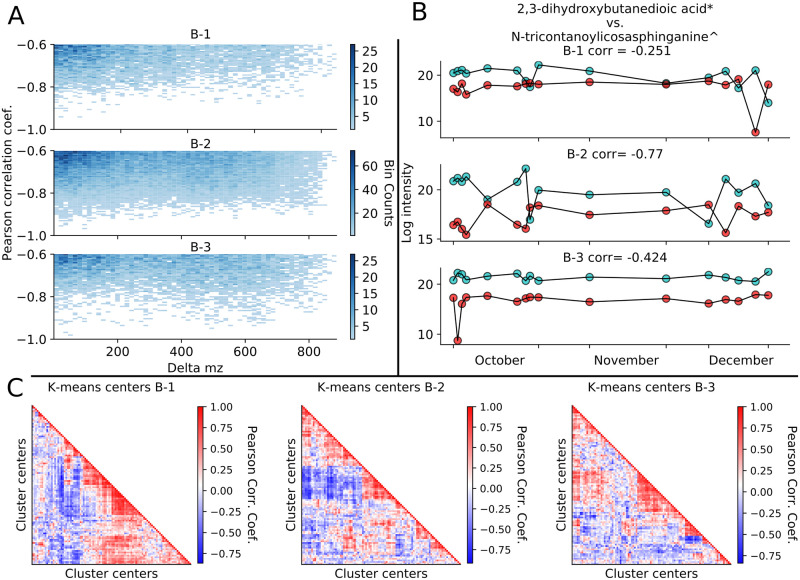
Individual building features and K-means cluster centers show anticorrelated temporal patterns.(A) 2-D histogram of pearson correlation between features versus their mass difference for each building showing only the anticorrelated region. (B) Example temporal profile of two features showing anticorrelated temporal behavior. Blue trace—2,3-dihydroxybutanedioic acid, red trace—N-tricontanoylicosasphinganine; * alternative compound—(s,s)-tartaric acid, ^ identification level 3. (C) Hierarchically clustered K-means centers with pairwise Pearson correlation coefficient.